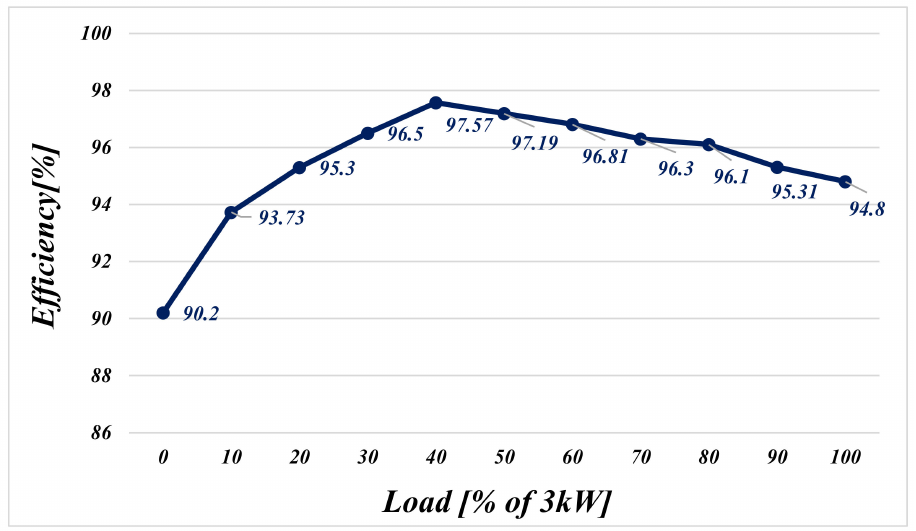
Figure 15. ESS efficiency waveform when the proposed algorithm was